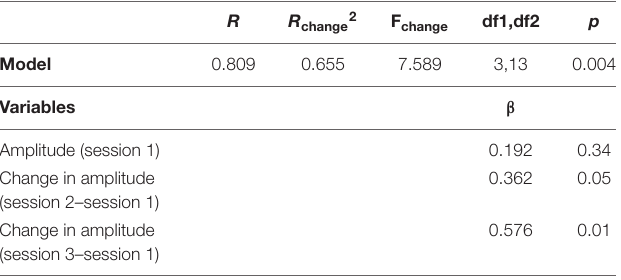
TABLE 2 | Regression model: Early sessions predicted neuroplastic changes after 6 months of hearing aid use.